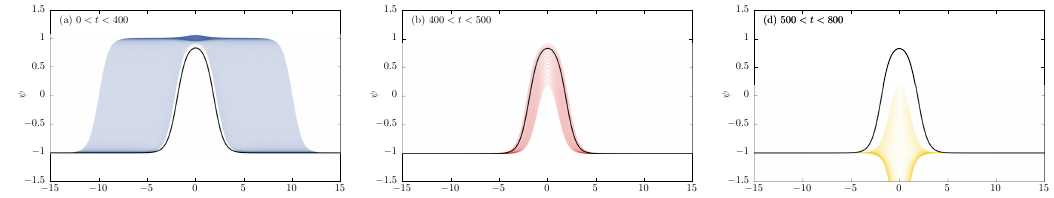
Figure 9 . Evolution of the field ψ obtained in the scattering of the initial configuration (5.1)–(5.2) with the purple mode ( n = 6) initially excited. Here A = 0 . 05 and solitons pass the SW.